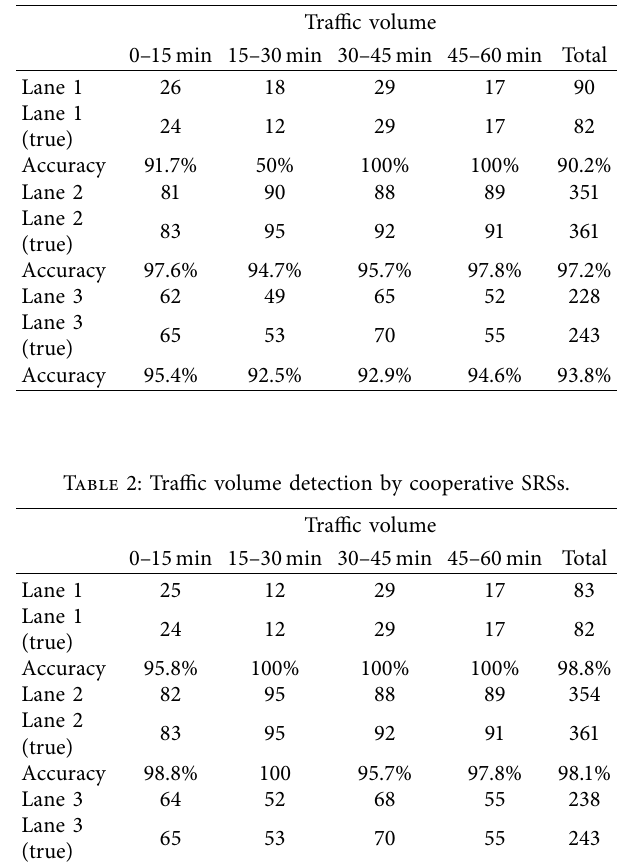
Figure 11: The experiment of an east-west road in Harbin. Table 1: Traffic volume detection by a single